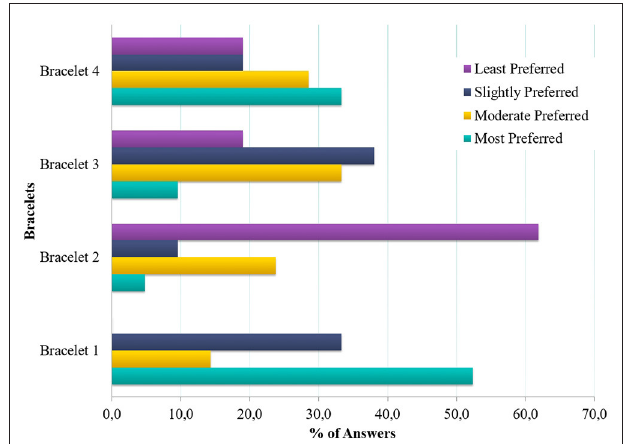
FIGURE 7 | Preferred order of Bracelets: percentage of PAB members who placed each bracelet in each place in an order of preference from 1 (most preferred) to 4 (least preferred).